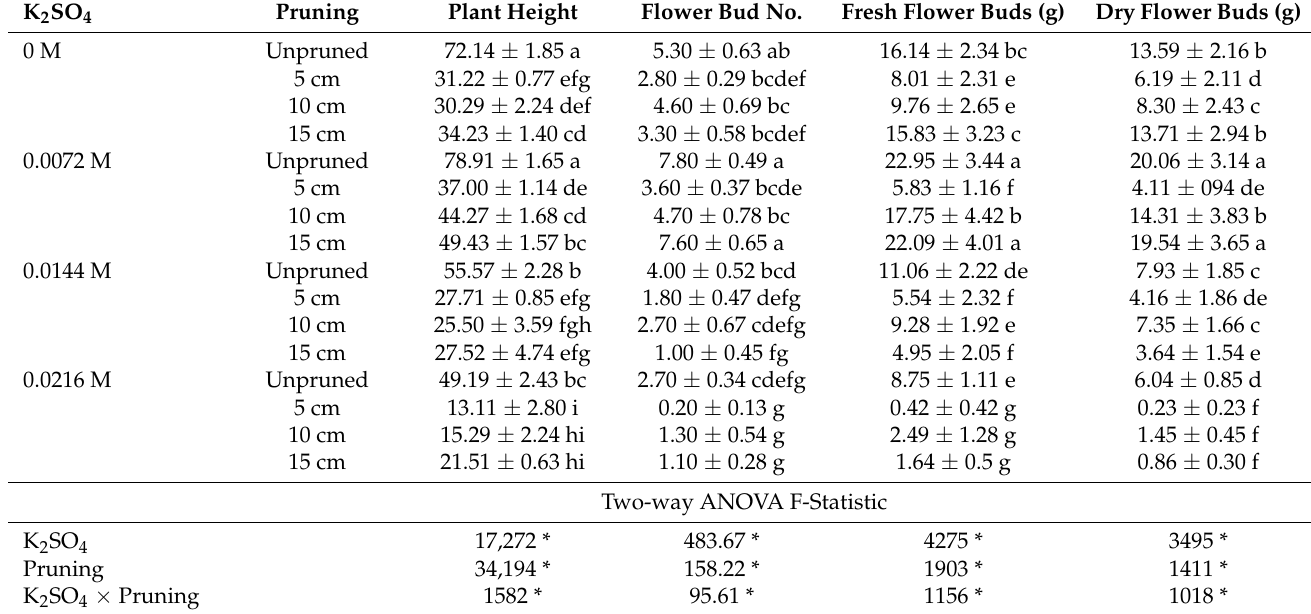
Table 1. The effect of potassium and pruning levels on plant height, flower bud number, and the fresh and dry weight of the flower buds of hydroponically grown T. divaricata